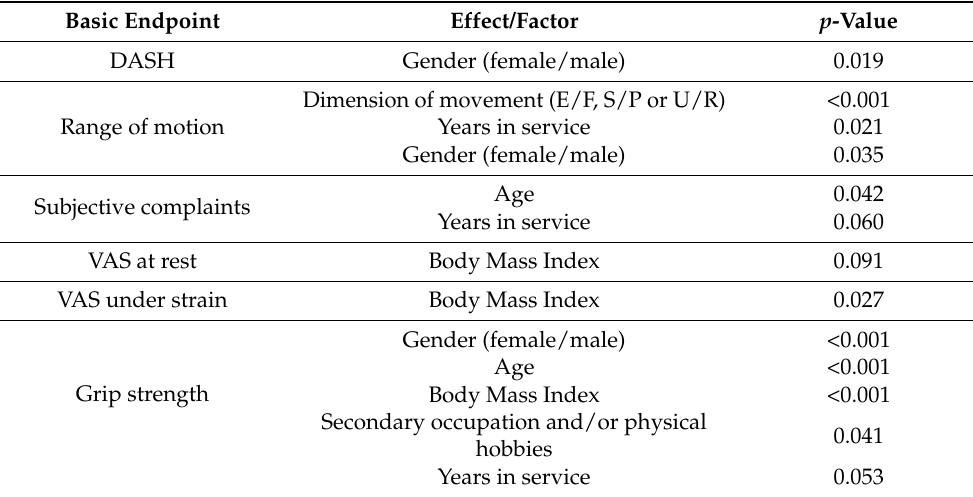
Table 6. Results of the multiple analysis of secondary clinical